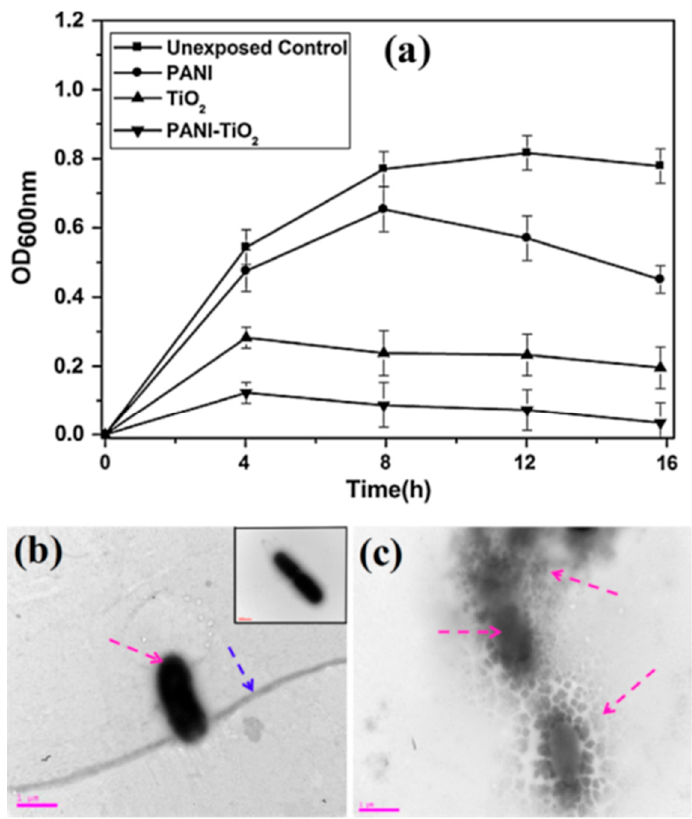
Figure 5. ( a ) The antibacterial performances of PANI–TiO 2 , TiO 2 , and PANI photocatalysts against E. coli , and TEM image of ( b ) E. coli (inset native E. coli ), and ( c ) E. coli treated with PANI–TiO 2 composite photocatalyst [30].